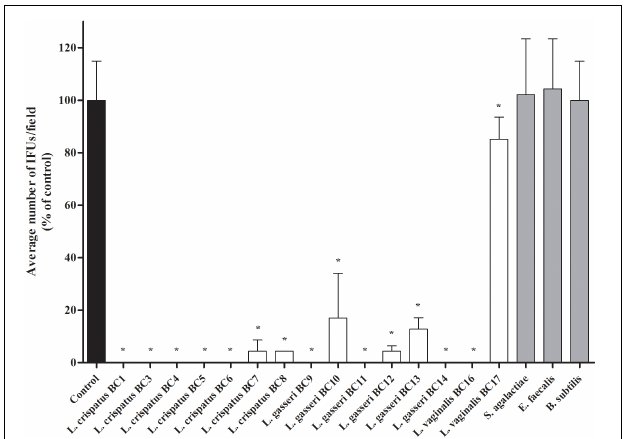
FIGURE 1 | Antagonistic activity of vaginal lactobacilli cells against Chlamydia trachomatis infectivity in exclusion assays. Exclusion experiments were performed at the dose of 5 × 10 7 lactobacilli cells in HeLa cells. Streptococcus agalactiae , Enterococcus faecalis, and Bacillus subtilis were used as reference Gram-positive bacteria. C. trachomatis infectivity was evaluated as number of IFUs/microscopic field. Results were expressed in percentage compared with control, taken as 100% (black bar). Bars represent median values, error bars represent median absolute deviations. Statistical significance was calculated vs. control. ∗ P ≤ 0.01.